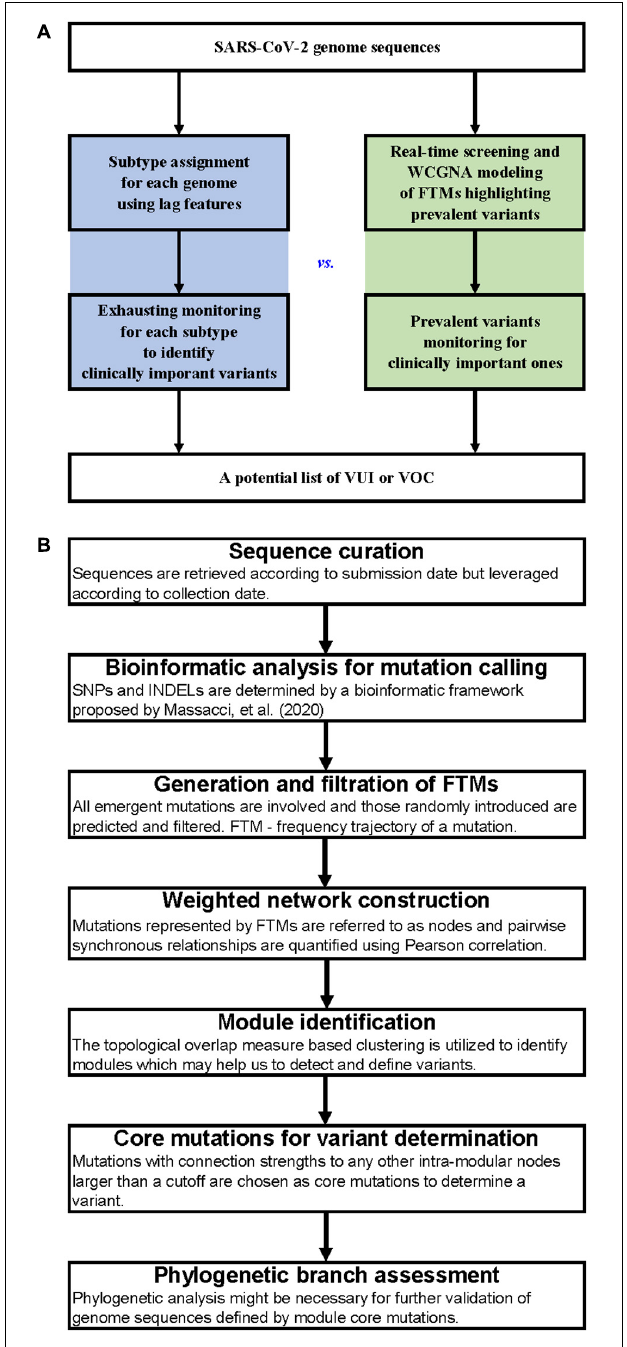
FIGURE 1 | Workflows for SARS-CoV-2 variant surveillance. (A) Workflow comparison between subtype-based and FTM-based variant surveillance methods. (B) Outline of a weighted network framework for variant surveillance using